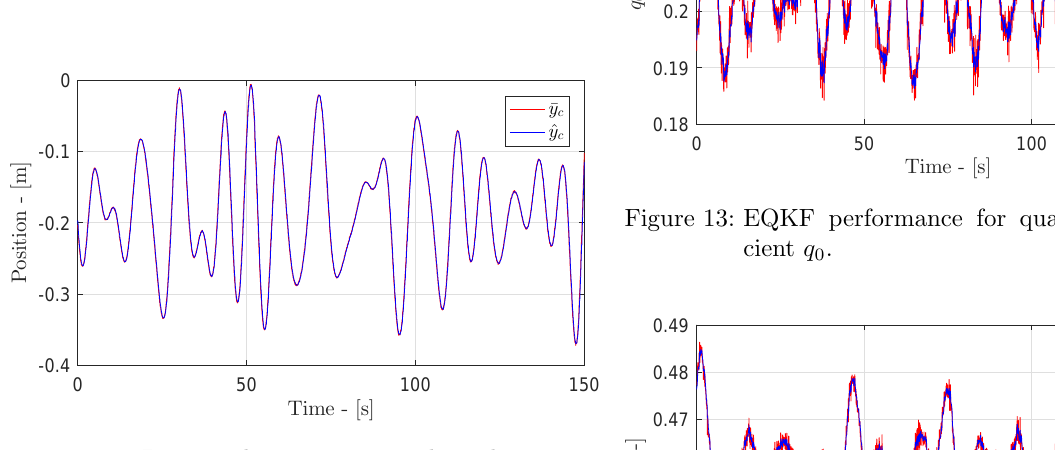
Figure 10: Positional comparison in the x-direction.